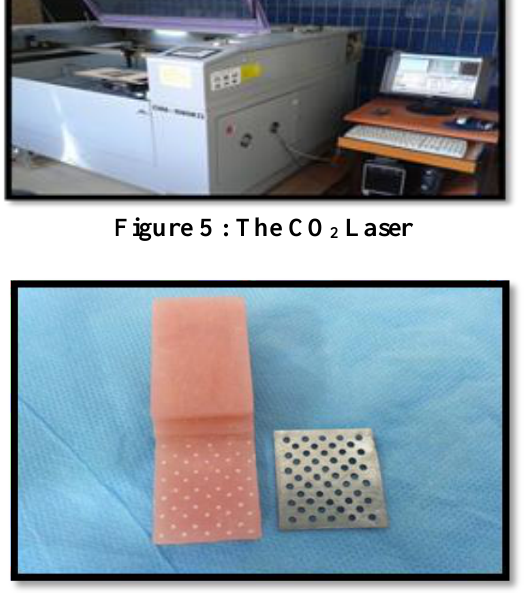
Figure 6:The surface treated acrylic specimens with CO